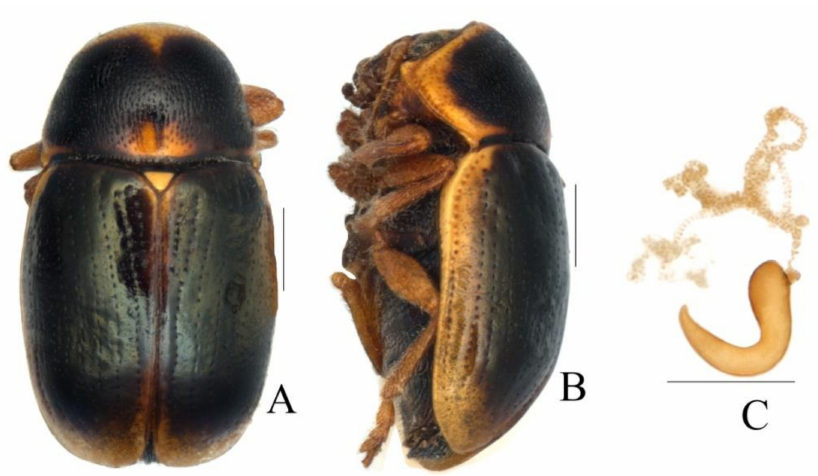
The distribution is China (Sichuan, Xizang).